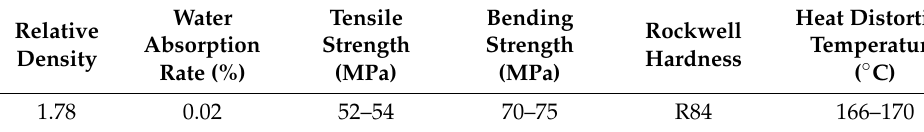
Table 3. Mortar specimen mix Table 2. Properties of PVDF materials.